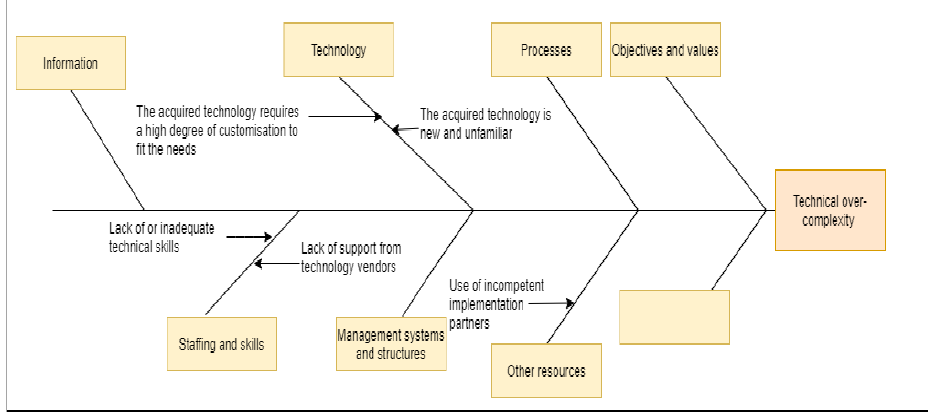
Figure 14: Technical